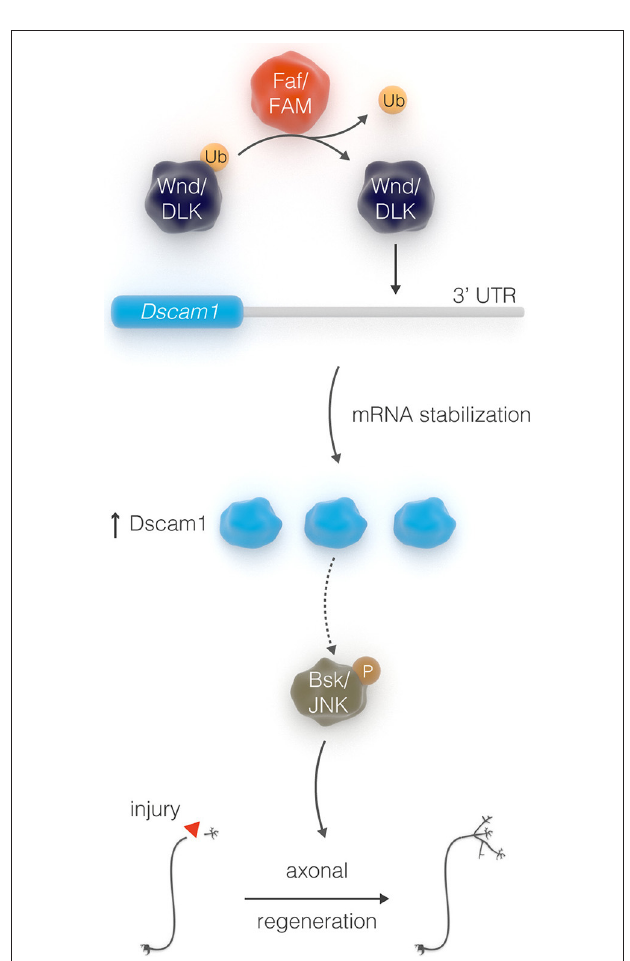
FIGURE 7 | Schematic depicting the interactions between Faf, Dscam, and JNK in axonal outgrowth.